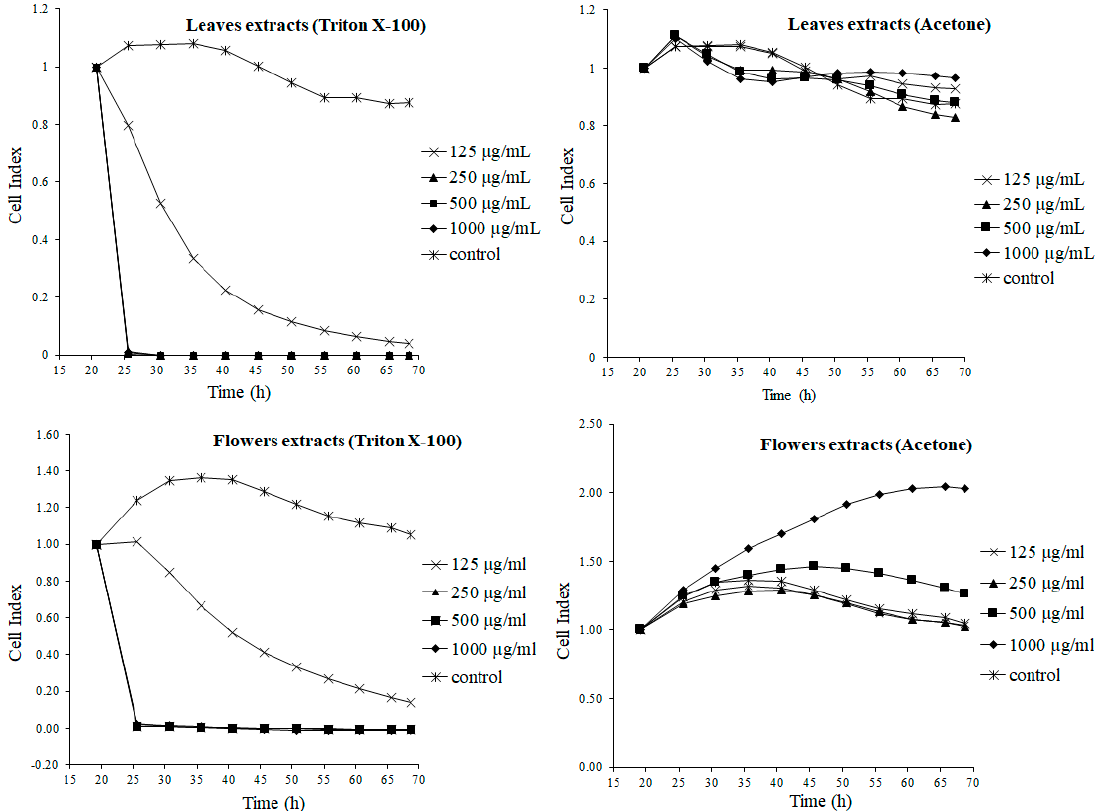
Figure 1. Real-time monitoring of dynamic cell changes, after 48 expositions to flowers and leaves extracts, prepared with the Triton X-100 and acetone.